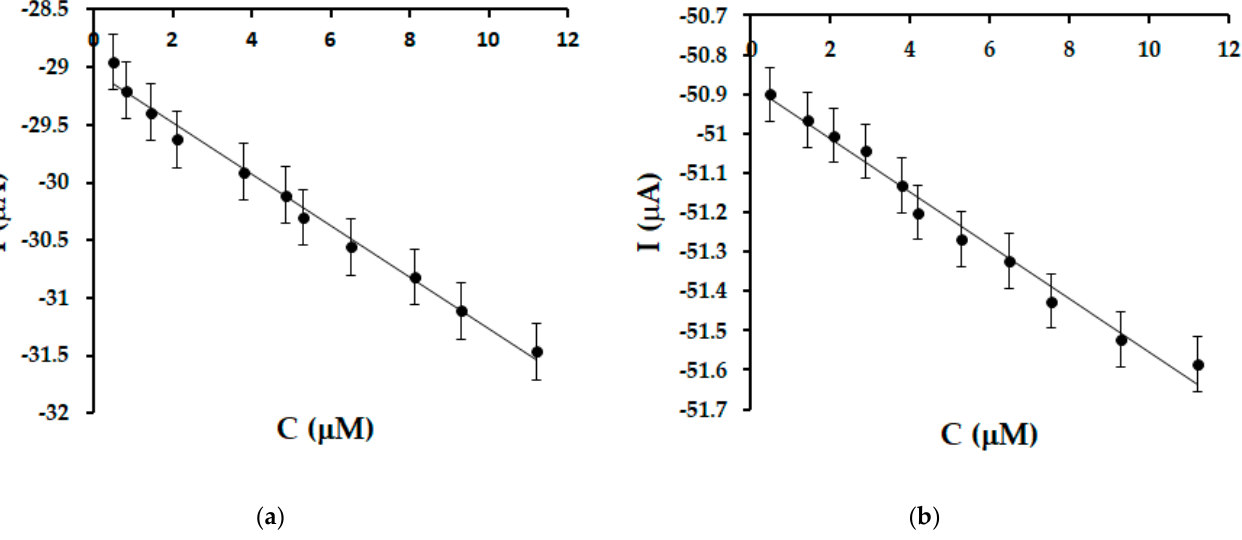
Figure 8. Linear fit in the range 0.49–11.22 μ M for SPE/SWCNT/Lac ( a ) and SPE/SWCNT/Tyr ( b ). A fairly wide linearity range was obtained in the range 0.49–11.22 μ M with a coefficient of determination values greater than 0.96 for both biosensors.